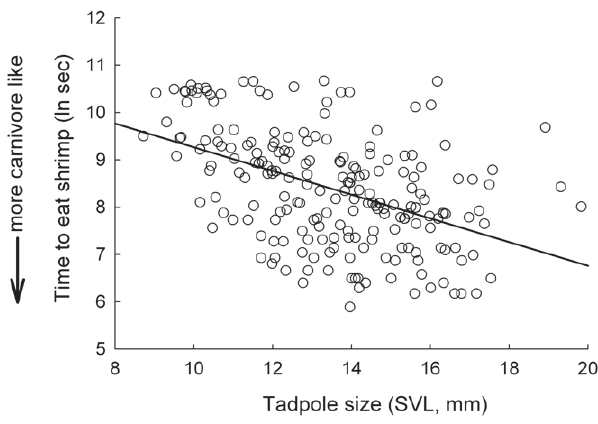
Figure 2. The relationship between tadpole size and foraging ability. Shown is tadpole size (SVL) and the time taken to eat three shrimp (ln sec) for 208 S. multiplicata tadpoles from 10 families. Shrimp foraging ability is a proxy for carnivore morph production, where faster shrimp eating times suggest a higher propensity for a tadpole to develop as a carnivore.